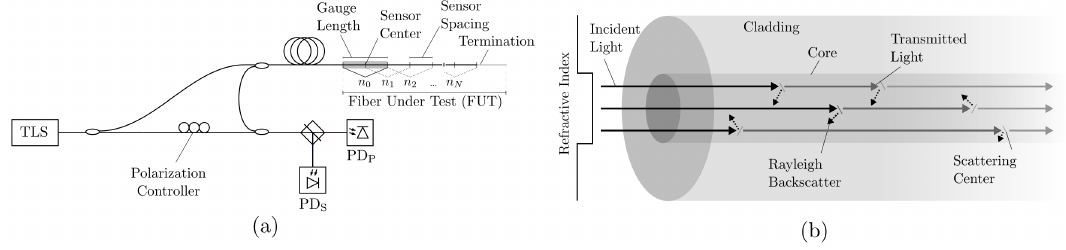
Figure 1. ( a ) Optical backscatter reflectometry (OBR) schematic showing how a tunable laser source (TLS) is used to produce an interference pattern resulting from Rayleigh backscatter along the fiber under test (FUT). The S - and P -polarization states are recorded separately by photodiodes PD S and PD P , respectively. The Fourier-transformed measurements are discretized into individual sensors or gauges (with indices n 0 , n 1 , . . . n N ) that can be analyzed separately to provide spatially distributed measurements. ( b ) Schematic of Rayleigh backscatter in a step-index singlemode optical fiber with light propagating through the fiber and reflected by local scattering